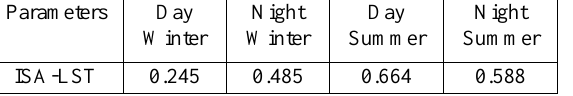
Table 2. Correlation coefficients between ISA and LST